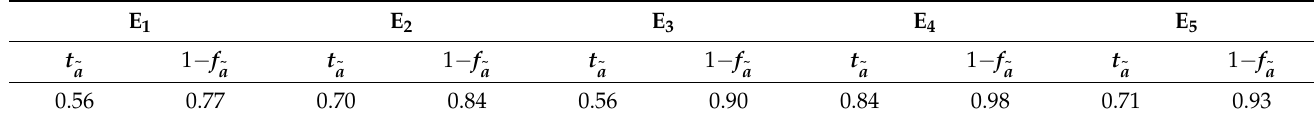
Table 8. Aggregation of the assessments of the different experts on each other.